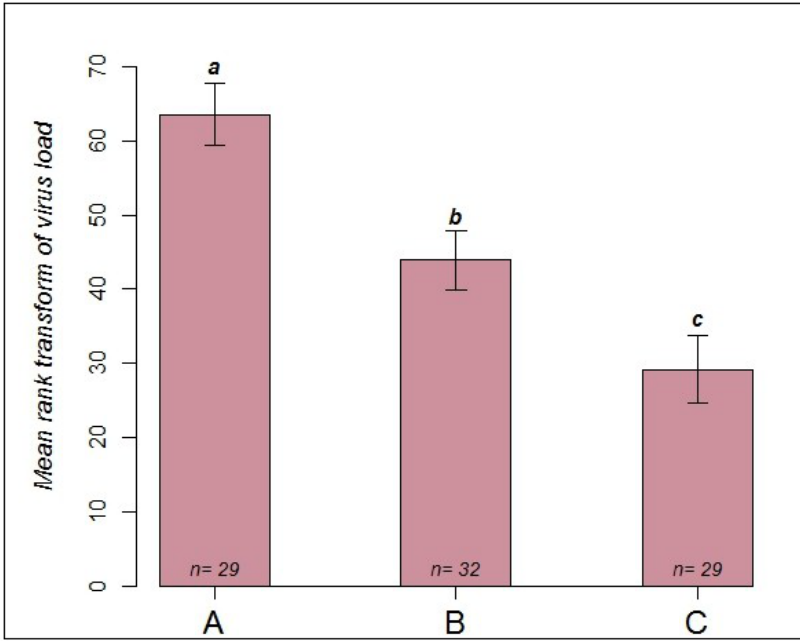
Figure 3. Comparison of mean rank transformed viral load among three groups of queens infected by different routes: Group A : queen with symptomatic bees in cage, in incubator, terminated on day 6 p.i.. Group B : topical infection with virus suspension, queen with asymptomatic bees in cage in incubator, terminated on day 6 p.i.. Group C : queen